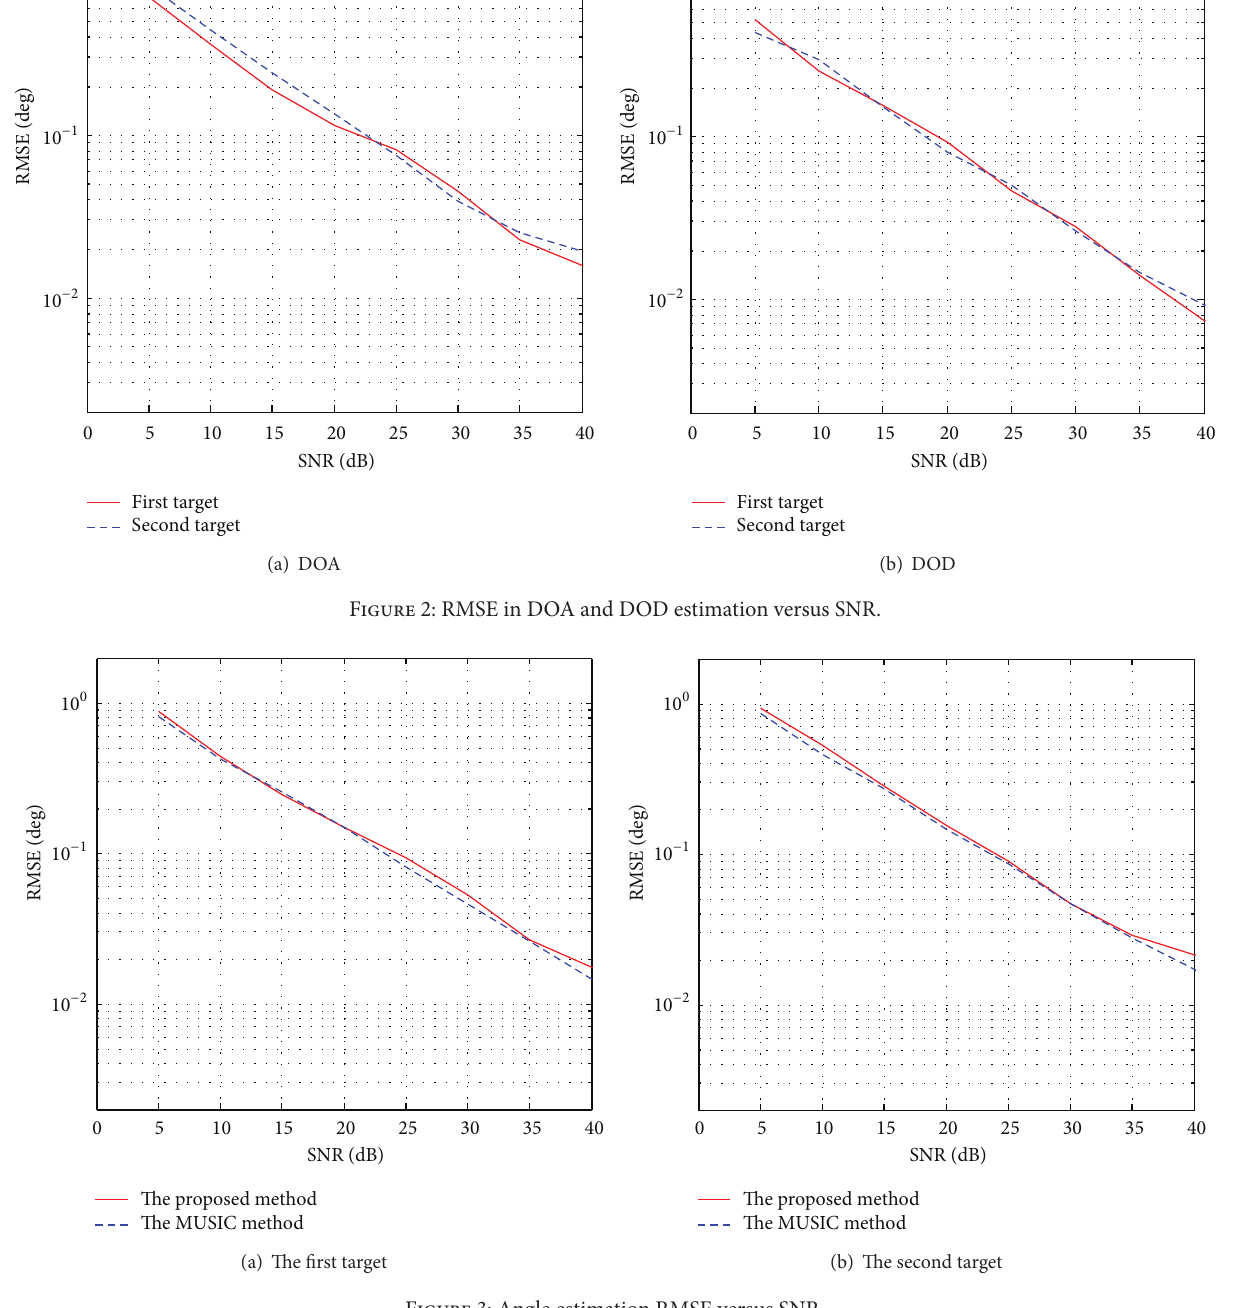
Figure 3: Angle estimation RMSE versus